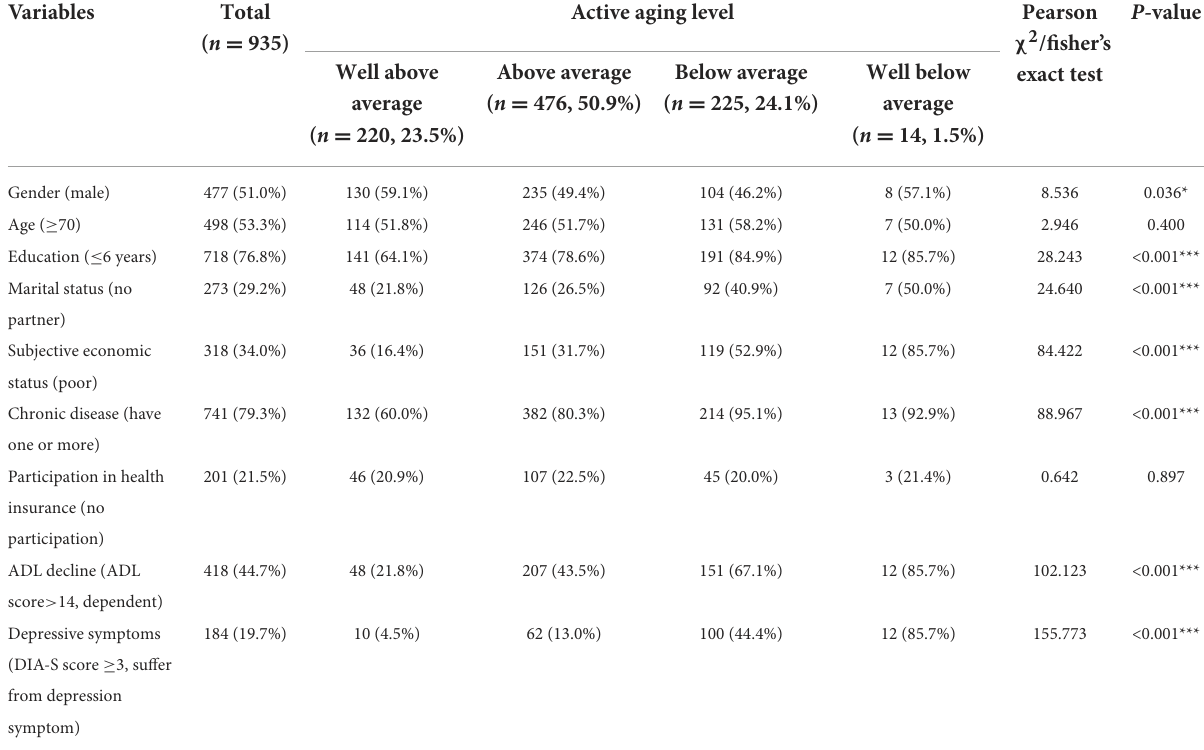
TABLE 1 Distribution of characteristics by active aging status ( n ,